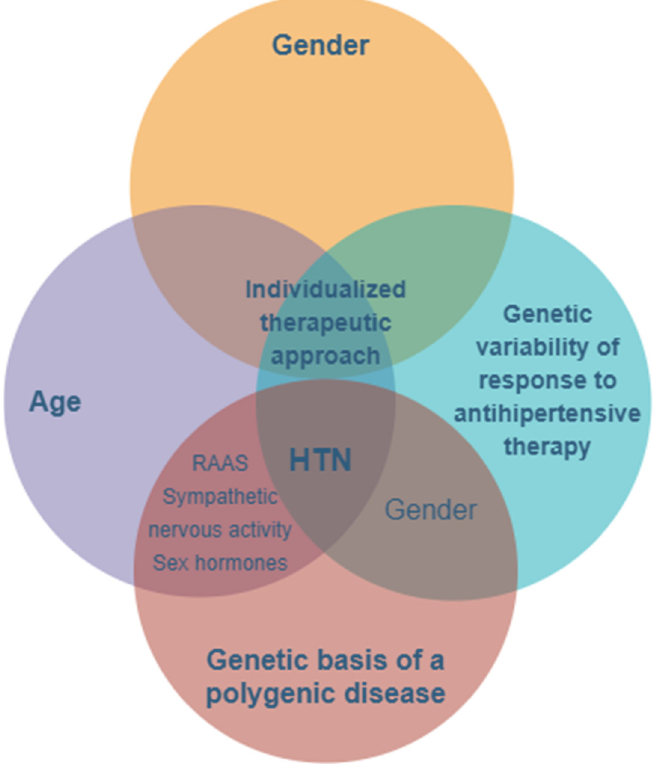
Figure 2. The main features and key factors for personalizing treatment in hypertension with a ge- netic- and gender-based substrate. HTN—hypertension; RAAS—renin–angiotensin–aldosterone system. aldosterone